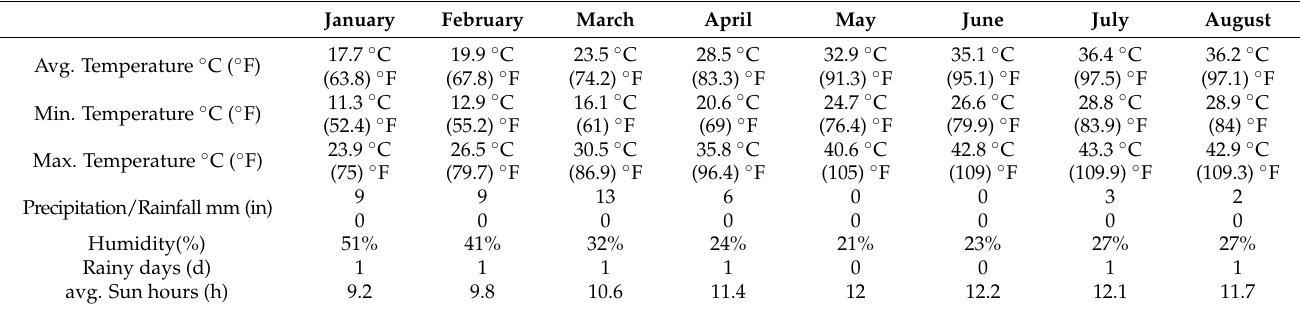
Table 1. Average 10 years data for temperature, humidity, and precipitation for the city of Al